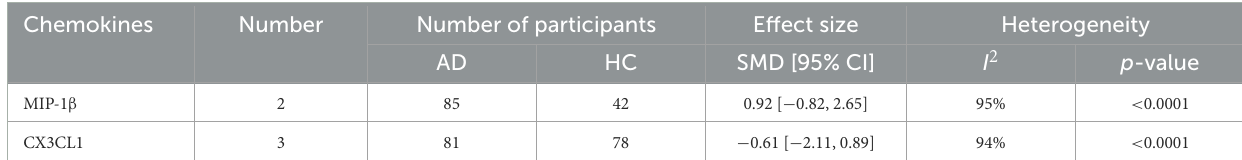
TABLE 3 The amount of chemokines in the CSF between AD patients and healthy controls. Chemokines